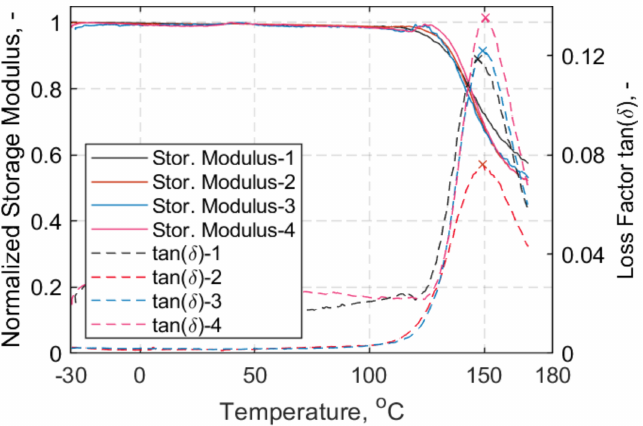
Figure 5. Normalized storage modulus vs. temperature ( ◦ C) (left); loss factor, tan δ (right). All samples -3PB